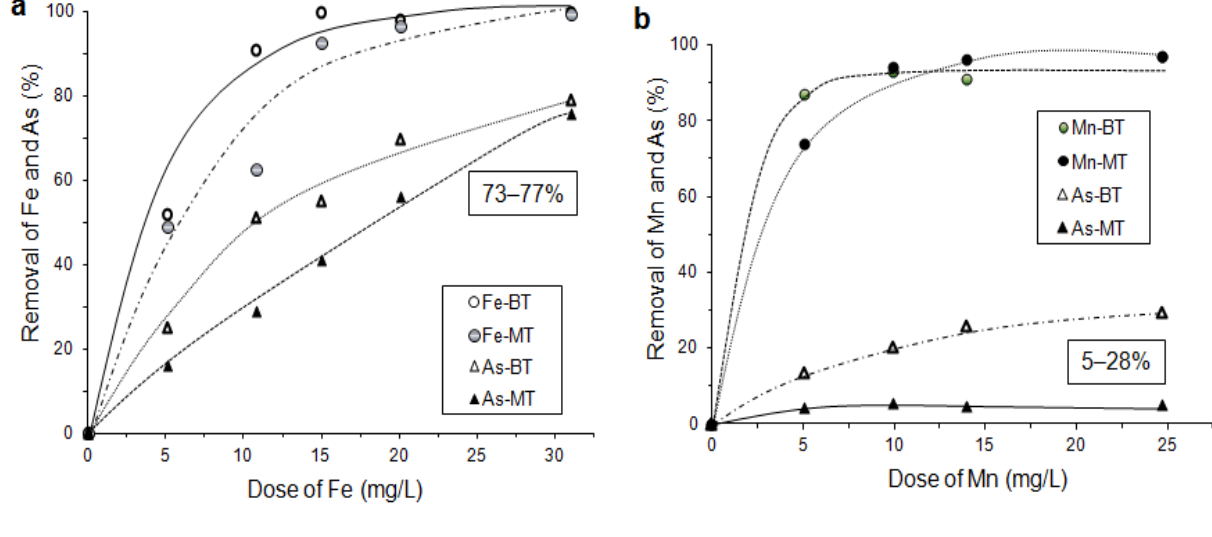
Figure 10. Adsorption efficiency of co-adsorption process; ( a ) Fe/As system, ( b ) Mn/As system; MT-kaolin, BT-bentonite (after